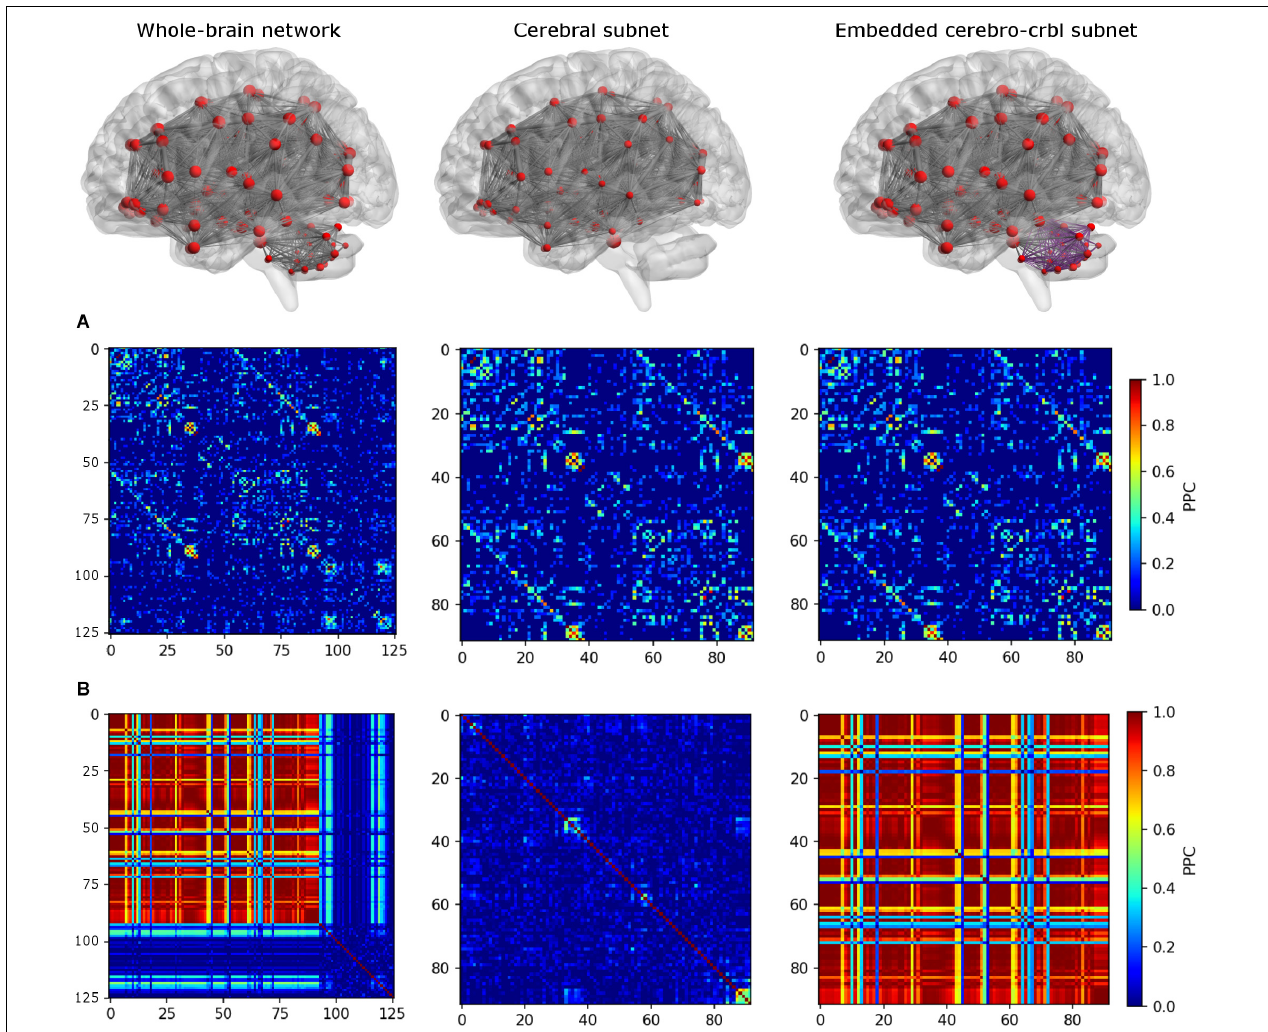
FIGURE 3 | Functional connectivity (FC) matrices for each network. The top row shows the connections of each network. From left to right: whole-brain network, cerebral subnetwork, embedded cerebro-cerebellar subnetwork . Nodes are represented in red, while edges connecting nodes for which simulated FC (simFC) was calculated are in gray. In the embedded cerebro-cerebellar subnetwork, cerebellar connections are represented in purple. The middle row (A) shows the empirical FC, while the bottom row (B) shows simFC matrices for each network. All matrices are taken from a randomly chosen subject. For simplicity, only the structural connectome (SC) construct that considers appropriate cerebro-cerebellar connections (i.e., the case that we named plusCRBL ) is shown, since the trend is the same in all SC